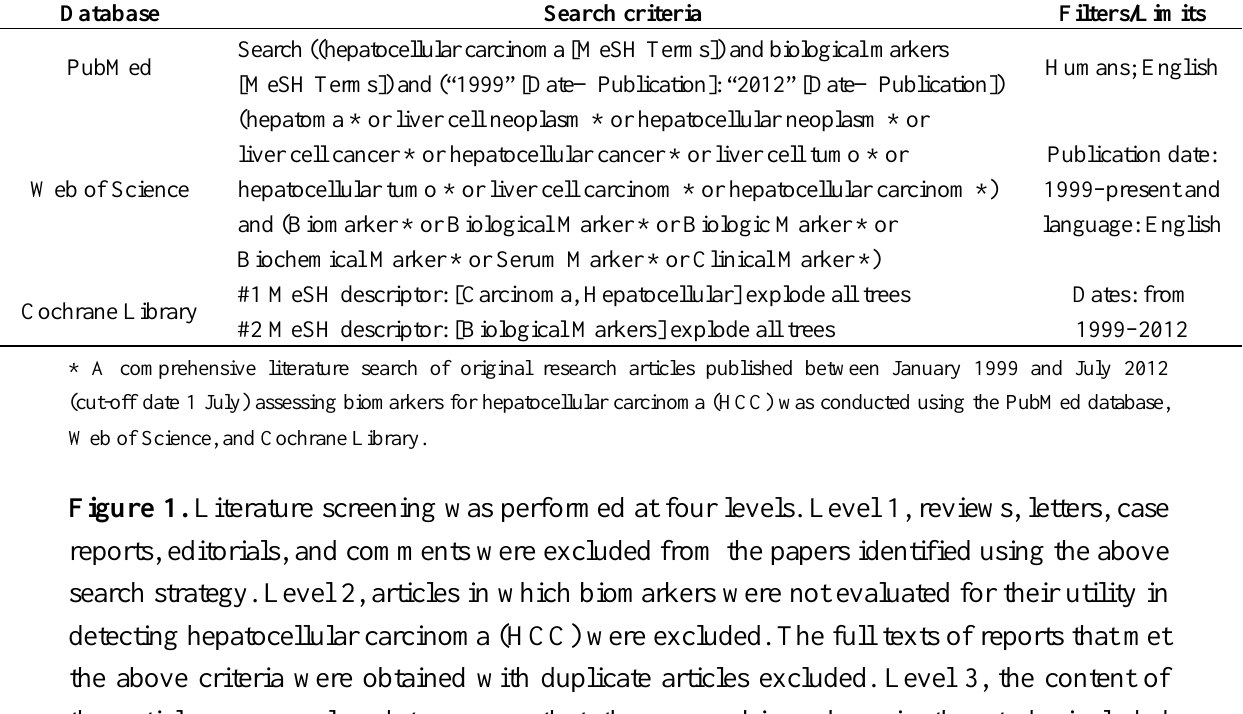
Table 1. Literature search strategy.